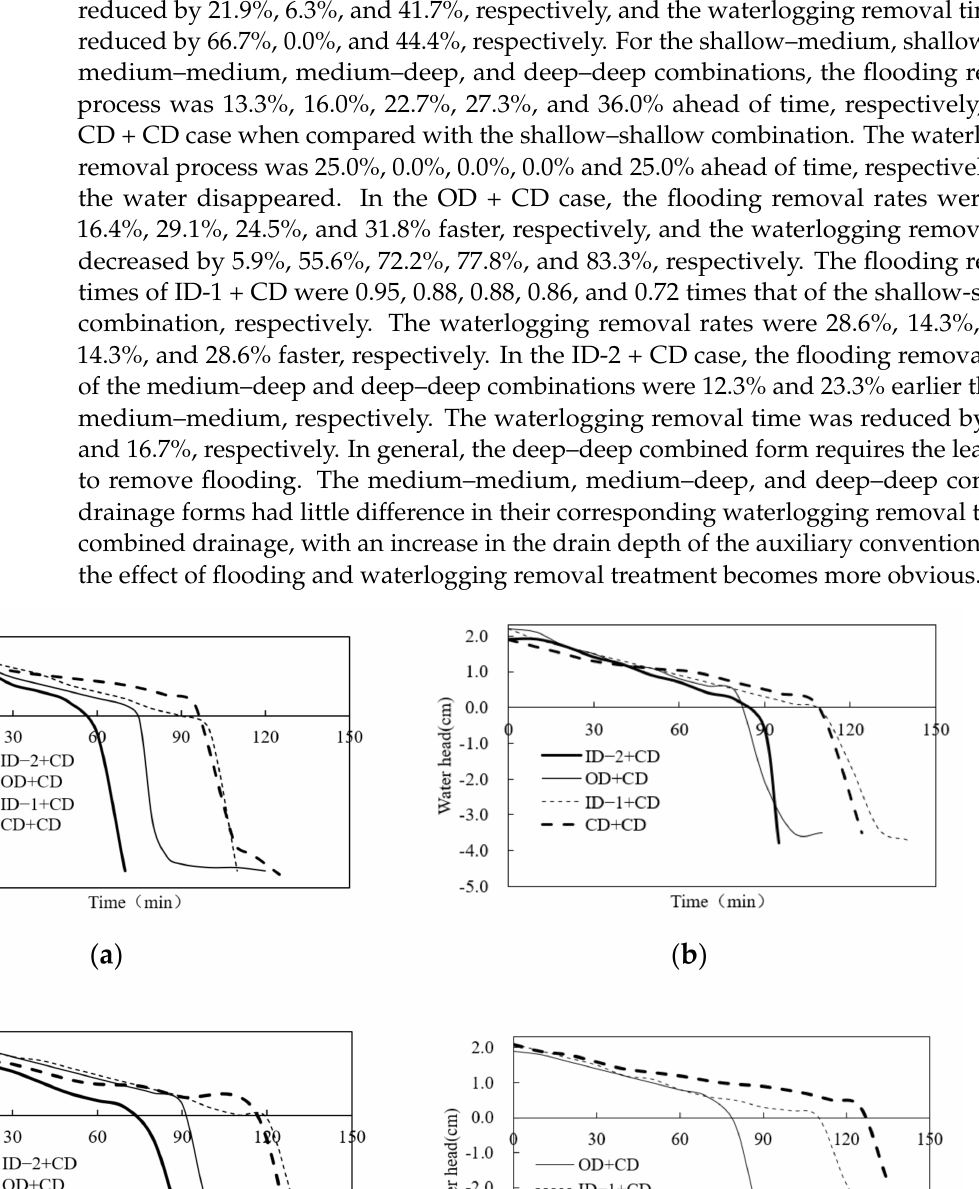
Figure 7. Flooding and waterlogging removal effect under different combined drainage forms; ( a ) Deep–deep combination; ( b ) Medium–deep combination; ( c ) Medium–medium combination; ( d ) Shallow–deep combination; ( e ) Shallow–medium combination; ( f ) Shallow–shallow combination. In general, the characteristics are as follows: with the increase in unit time of discharge, the time taken for the 2.0 cm of ponding water to disappear decreases, and the water head decreases with a fixed slope over time from the beginning of ponding water recession. When there is no ponding water, the water head decreases rapidly to a low level within a short time. Subsequently, the water head remained relatively stable and was maintained at a height equivalent to the drain depth of the deeper ditch (pipe, improved subsurface drainage). The flow rate of the drainage pipe was relatively slow, and the drainage time was long. At the same time, it can be found that the combined drainage can greatly reduce the time needed to remove the ponding water by taking advantage of the benefits of the open-ditch and improved conventional drainage. The auxiliary conventional subsurface drainage has the advantage of waterlogging removal in farmland, which can reduce the time required for groundwater levels to fall below the plow layer. Overall, OD + CD and ID-2 + CD have great advantages for the entire flooding and waterlogging removal processes.